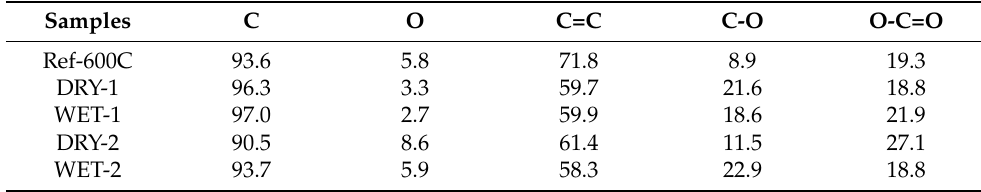
Table 1. Surface chemical composition determined by XPS in at%.